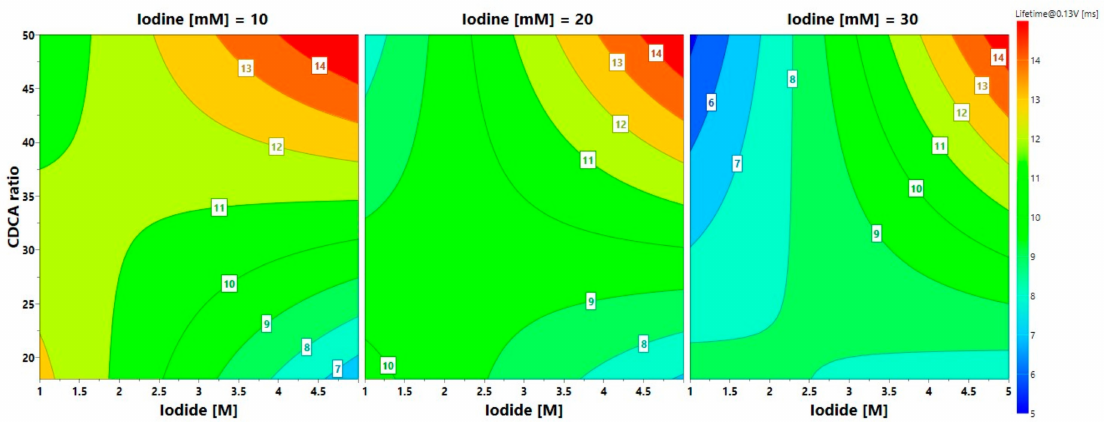
Figure 6. Isoresponse contour plots of electron lifetime as a function of di ff erent experimental